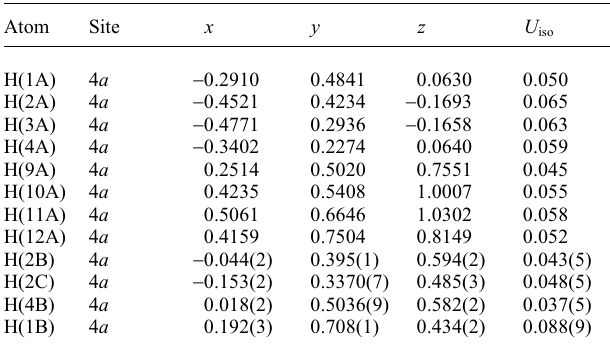
Table 2. Atomic coordinates and displacement parameters (in Å 2 )